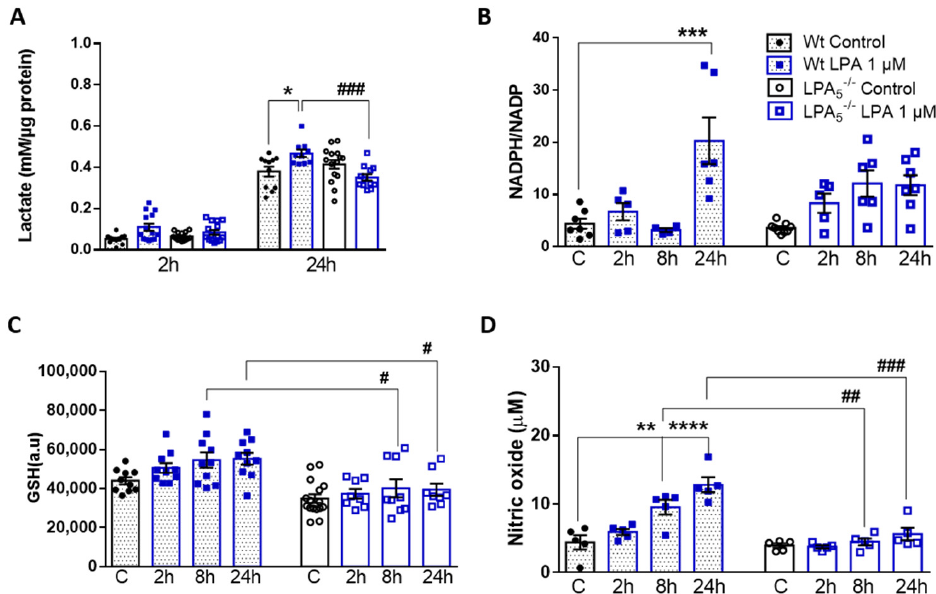
Figure 6. LPA 5 regulates extracellular lactate content, NADPH/NADP ratio, glutathione concentra- tion, and NO production in primary microglia. Wt and LPA 5-/- cells were cultivated in serum-free medium in the absence or presence of LPA (1 µ M). ( A ) Lactate content was measured by EnzyChrom™ Glycolysis Assay Kit. ( B ) NADPH/NADP ratio was measured using the NADP/NADPH assay kit (Abcam). ( C ) Glutathione (GSH) concentration was quantified with the GSH-Glo Assay kit. ( D ) The production of NO was determined by measuring the total nitrate concentration in the supernatants. Results are presented as mean values ± SEM of three independent experiments. * p < 0.05, ** p < 0.01, *** p < 0.001, **** p < 0.0001 compared to wt controls, # p < 0.05, ## p < 0.01, ### p < 0.001 for LPA 5-/- compared to wt cells, two-way ANOVA with Bonferroni correction.